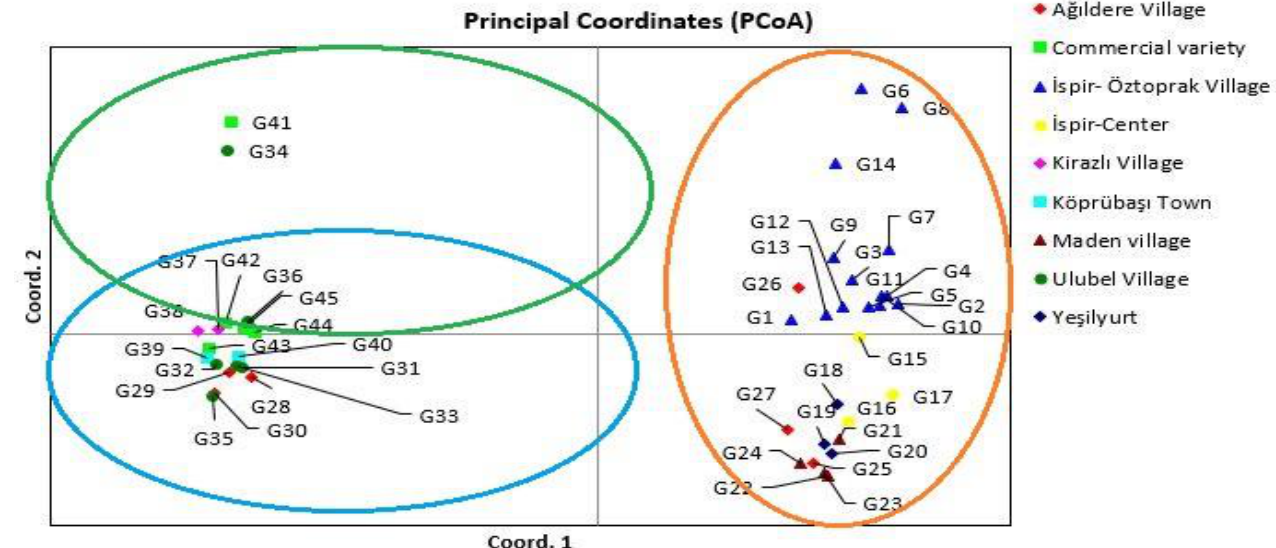
Figure 2. Dendrogram of 45-bean varieties generated with data from 26 inter primer binding site (iPBS) primers.